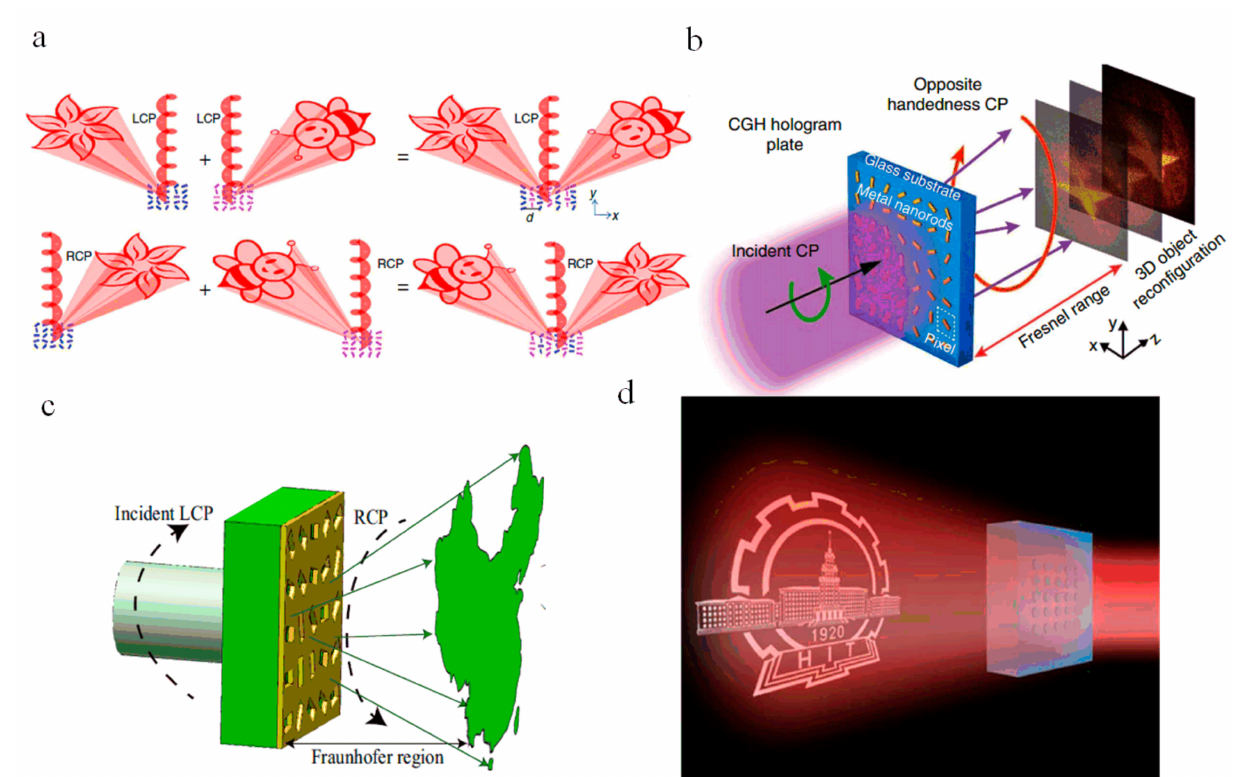
Figure 1. ( a ) Diagram of a helicity-multiplexed hologram realized by a reflective PB-phase metasurface. Reprinted with permission from ref. [48]. Copyright 2015 Springer Nature. ( b ) Transmissive-type three-dimensional optical holography by a plasmonic metasurface. Reprinted with permission from ref. [50]. Copyright 2013 Springer Nature. ( c ) A schematic diagram of the designed meta-hologram under LCP illumination and an image with RCP in the Fraunhofer region. Reprinted with permission from ref. [52]. Copyright 2016 Springer Nature. ( d ) An image of the Huygens’ metasurface hologram. Reprinted with permission from ref. [53]. Copyright 2016 Springer